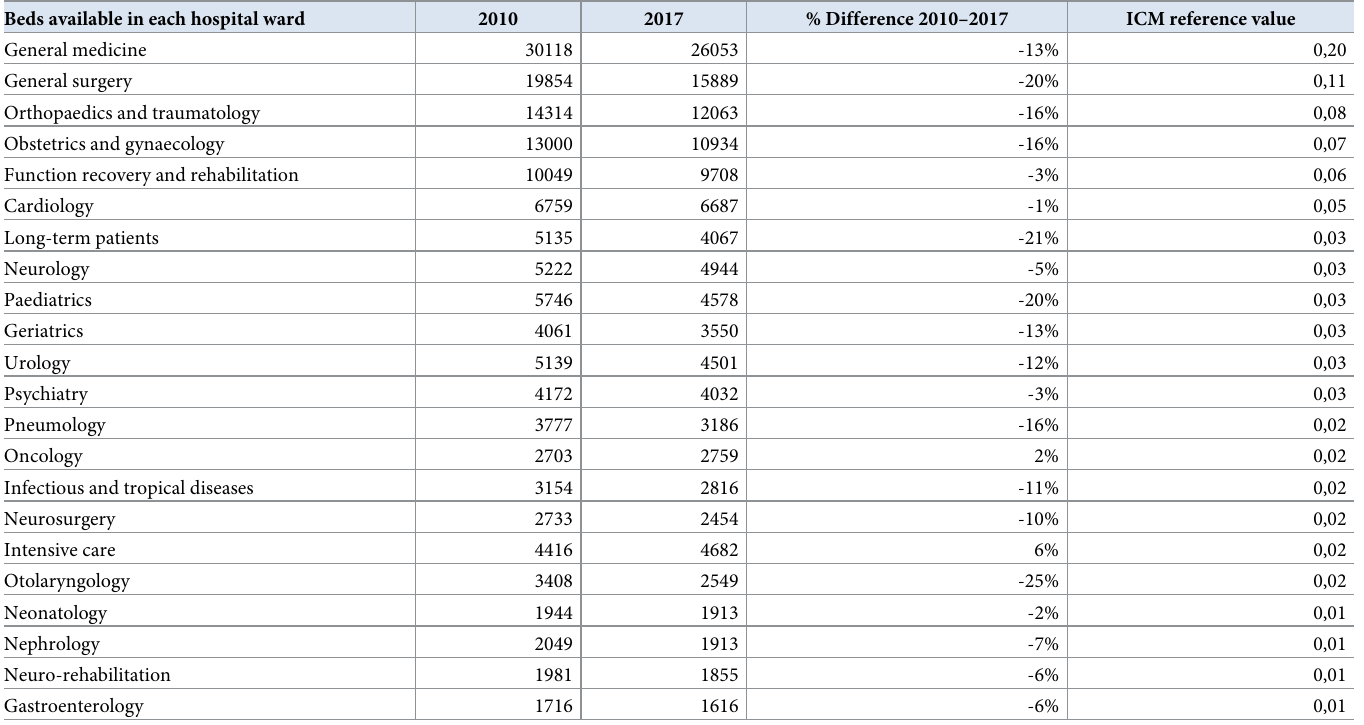
Table 3. Number of beds in the years 2010 and 2017 highlighting the differences in each hospital ward. Beds available in each hospital ward